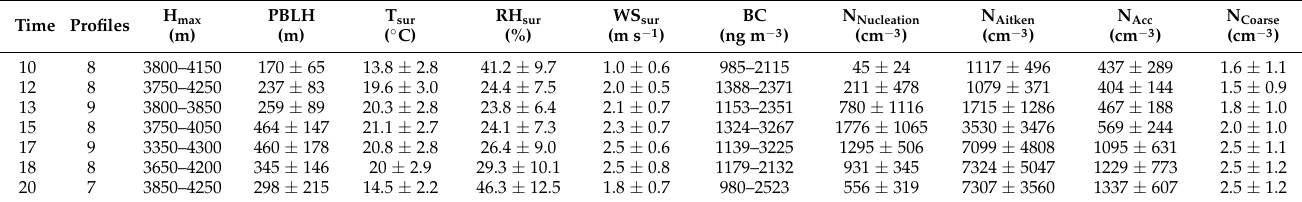
Table 1. Statistical summary of launches and near-ground parameters. H max and PBLH are the maximum height reached by the UAVS and planet boundary layer height, respectively. T sur , RH sur , WS sur , BC, N Nucleation , N Aitken , N Acc , and N Coarse denote the temperature, relative humidity, wind speed, mass concentration of BC, number concentration of nucleation aerosol (10–20 nm), Aitken aerosol (20–100 nm), accumulation aerosol (100–1000 nm), and coarse aerosol (1.0–10.0 µ m), respectively, near the ground, presented as the average value ± standard